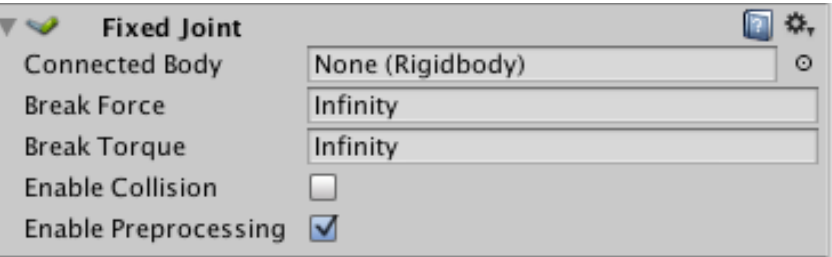
Figure 23. “ Fixed Joint ” component.